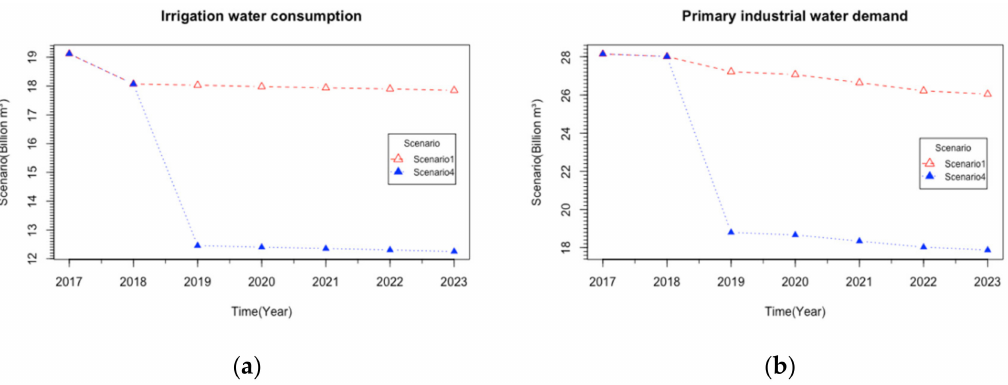
Figure 11. Scenario 4 simulation results: ( a ) Trend of irrigation water consumption; ( b ) Trend of primary industrial water